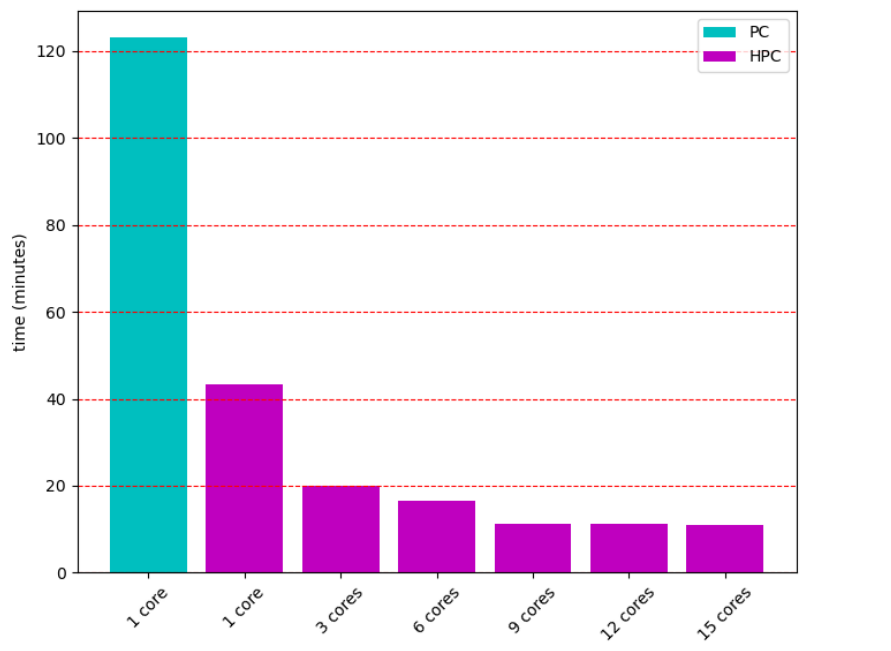
Figure 11. Execution time on a PC (cyan) and HPC cluster (magenta) for a different number of